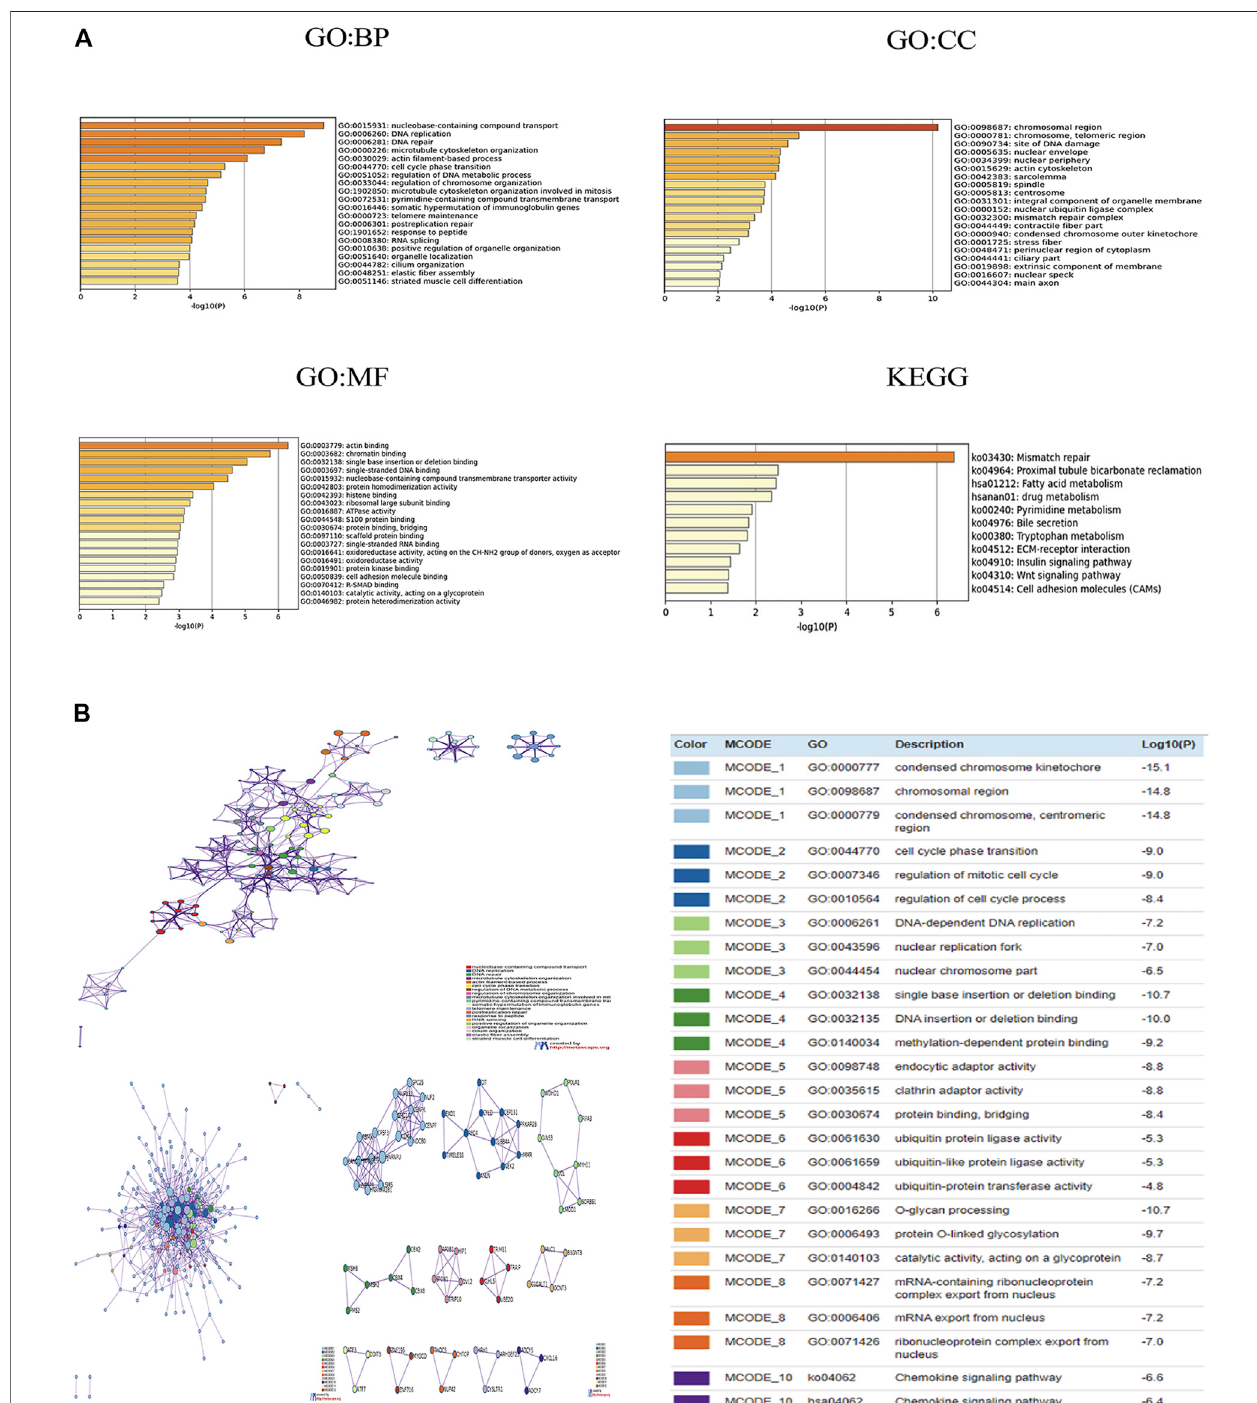
FIGURE 6 | (A) Gene Ontology (GO) analysis and Kyoto Encyclopedia of Genes and Genome (KEGG) analysis of CBX genes and similar genes. (B) Network of enriched terms of CBX genes and similar genes; Protein-protein interaction (PPI) enrichment analysis of these genes and MCODE (Molecular Complex Detection) components identi fi ed in the gene lists. Analyses were conducted in in fi ltration of macrophages (Cor = 0.263, p = 3.62e-04). There negative correlation between CBX6 expression and the was a positive correlation between CBX7 expression and the in fi ltration of CD8 + T cells (Cor = -0.167, p = 2.51e-02), and a positive correlation between CBX6 expression and the in fi ltration of B cells (Cor = 0.254, p = 5.87e-04), CD4 + T cells